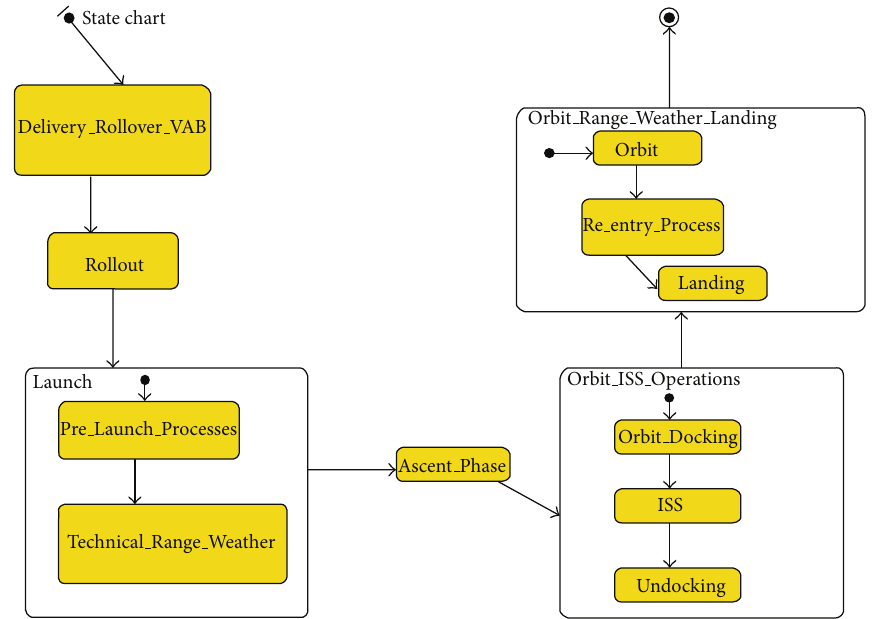
Figure 6: State chart of a mission to the ISS using AnyLogic (http://www.anylogic.com/) for the MPCV and SLS.